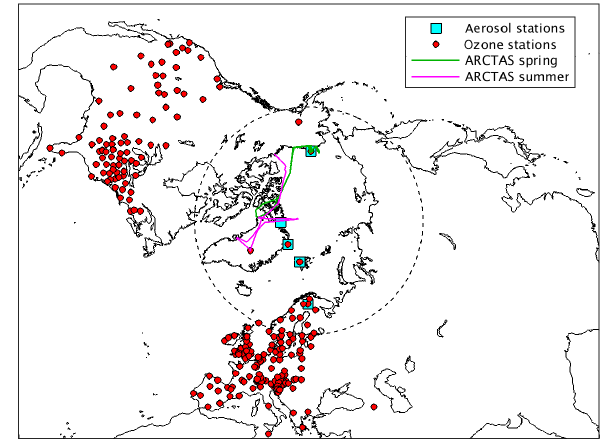
Figure 1. WRF-Chem simulation domain and location of the mea- surements used in this study. Stations measuring ozone are shown as red circles. Arctic aerosol measurement sites (BC and sulfate) are shown as blue squares. ARCTAS spring and summer flight tracks north of 70 ◦ N (as in Eckhardt et al., 2015) are shown in green and pink,